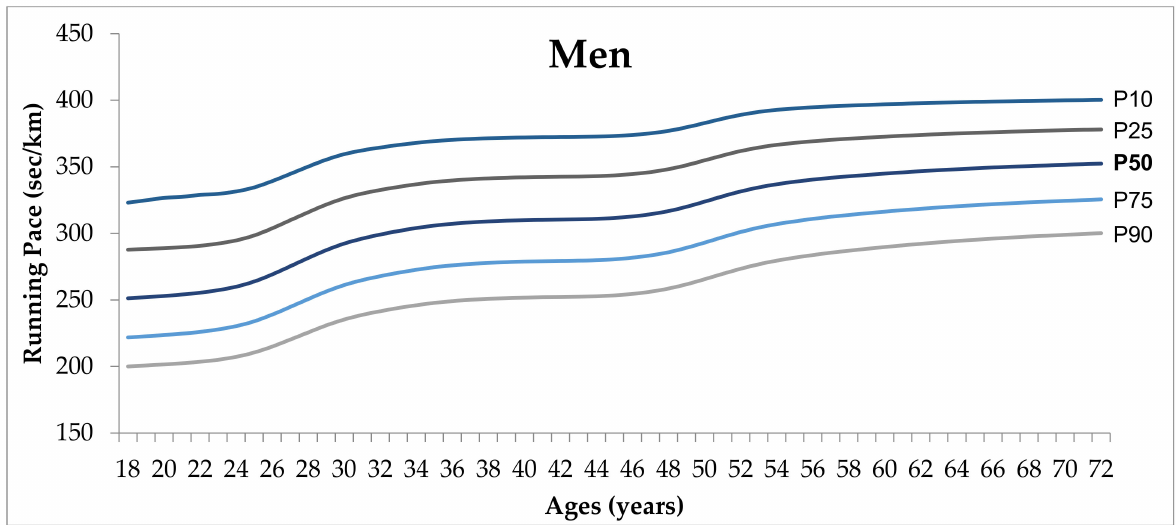
Figure 1. Percentile graph representing P10, P25, P50, P75, P90, of running pace for men, aged 18–72 years.